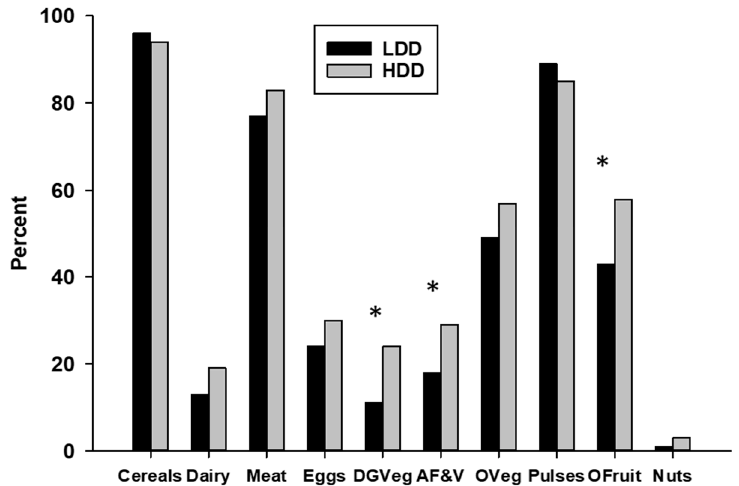
Figure 4. Percentage of LDD and HDD female small holder farmers who produced each of the 10 different food groups used to determine food crop diversity. * Chi-Square analyses, p < 0.05) LDD vs. HDD. Abbreviations: Cereals = grains, white roots and tubers, and plantains; Meat = meat and poultry; DGVeg = dark green vegetables; AF&V = vitamin A-rich fruits and vegetables; OVeg = other vegetables; OFruit = other fruits; Nuts = nuts and